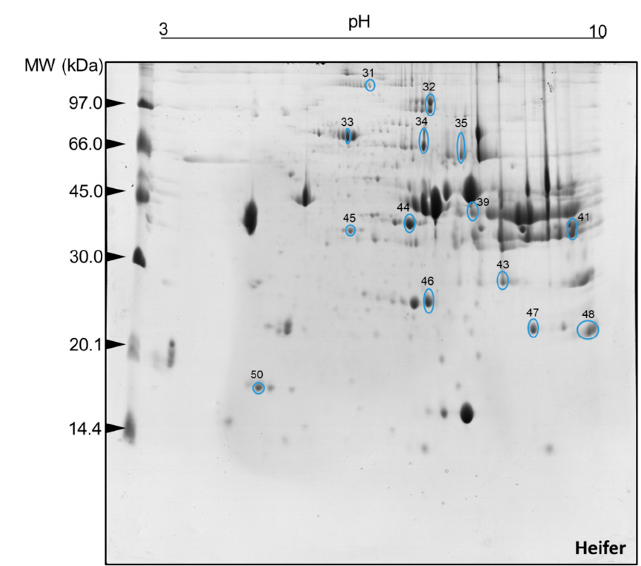
Figure 1. Protein spots selected for characterization by mass spectrometry (ESI-MS) after im- age analysis. Two-dimensional polyacrylamide gel electrophoresis (2D-PAGE): 12.5% ( w / v )